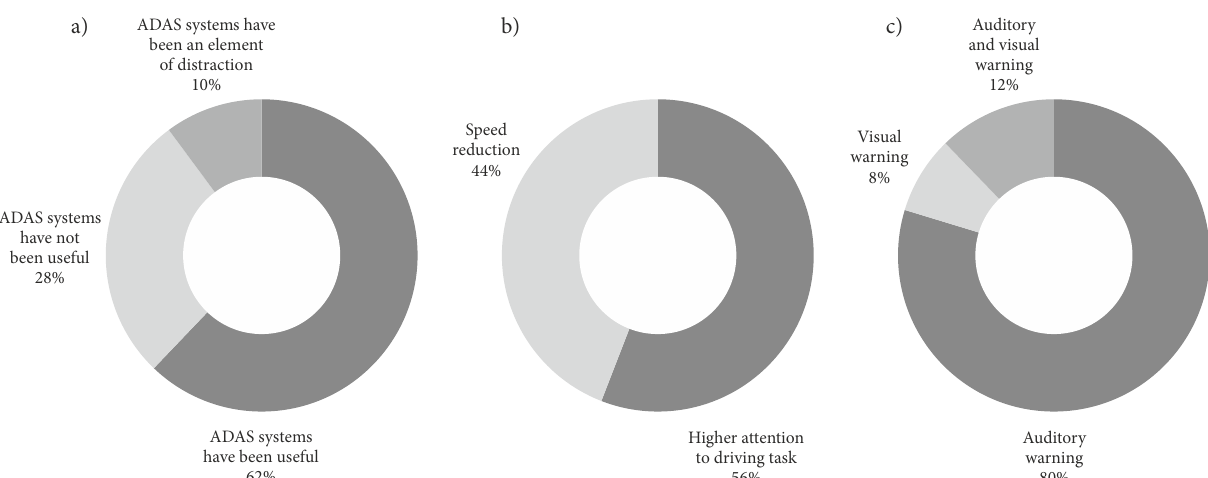
ADAS systems have been Figure 6. Outcomes of the questionnaire for the kind of ADAS: a – influence; b – consequence; c – preference